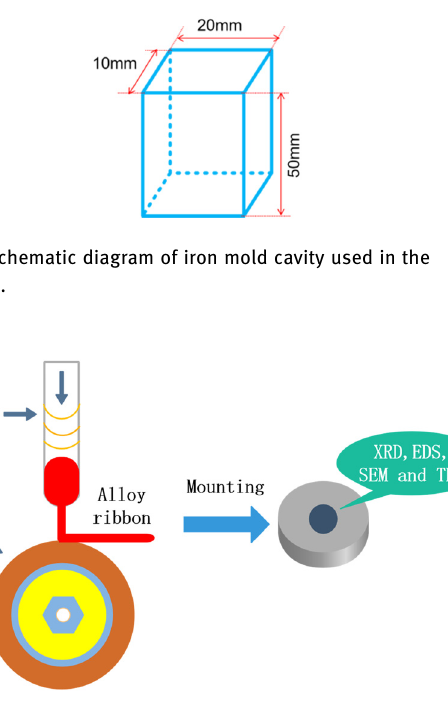
Figure 3: The process fl owchart of the single copper roller melt - spinning